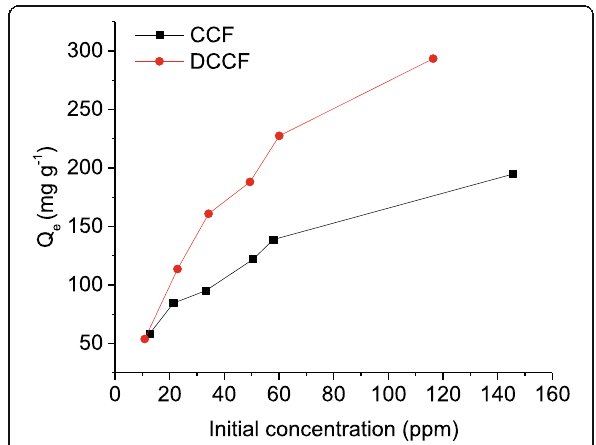
Fig. 7 Effects of initial MB concentration on the equilibrium adsorption capacity of CCF and